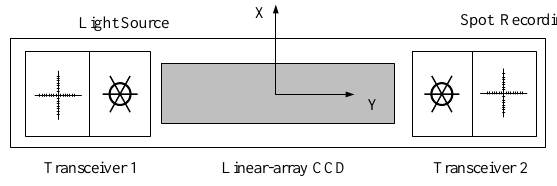
Figure 3. Schematic diagram of focal plane